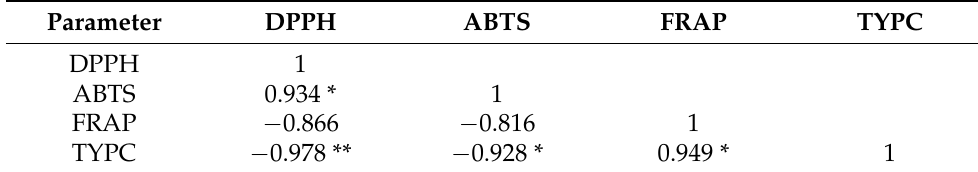
** indicated extremely significant correlation ( p < 0.01); * represents significant correlation ( p <